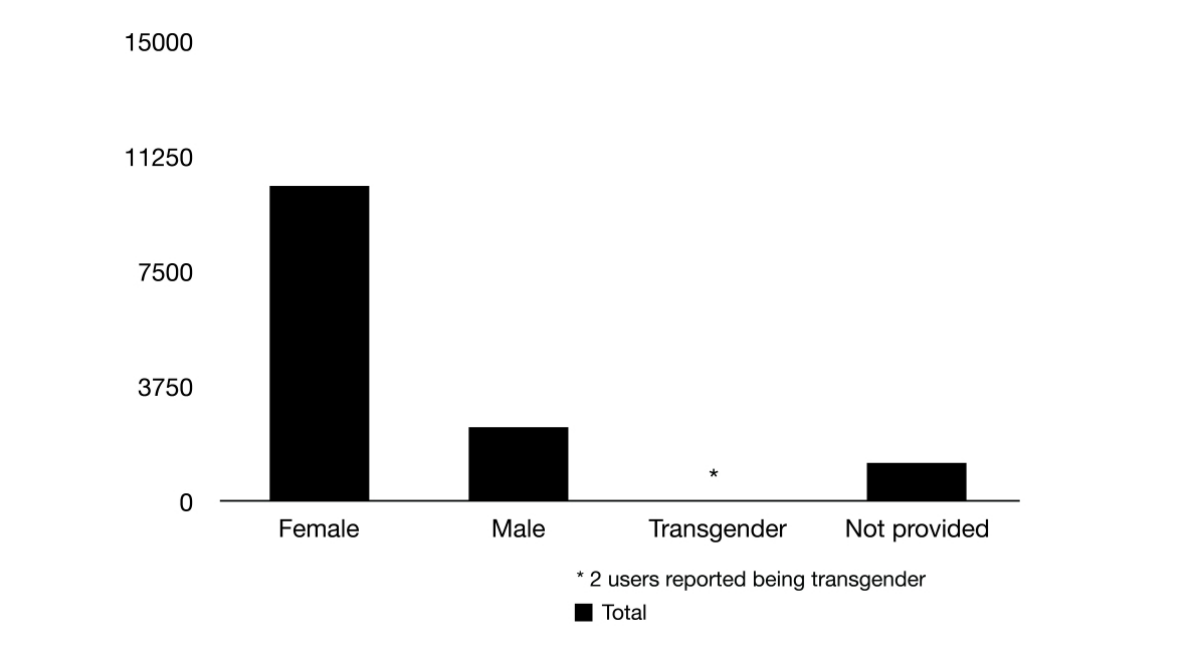
Figure 2. Gender distribution disclosed by users who reported their migraine headache attacks (n=14,028). 73.47% female (10,306 subjects), 17.40% male (2441 subjects), 0.01% (2 subjects) self-reported as transgender, and 9.12% was not provided (1279